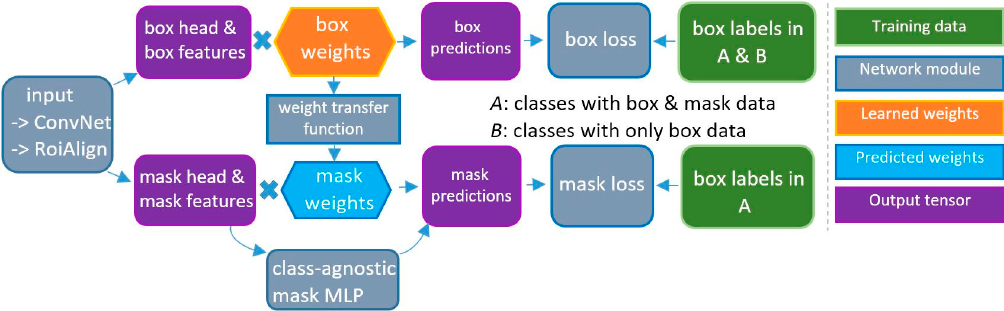
Figure 4. Detailed illustration of Mask X R-CNN method (adapted from [10]).